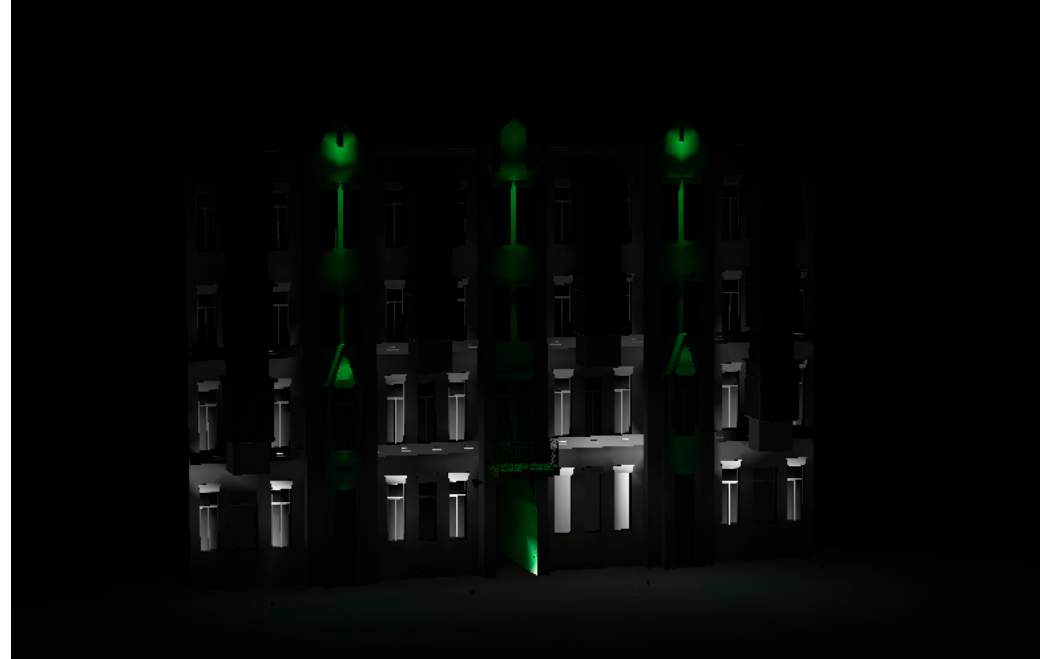
Figure 40. Energy and light pollution limitation scenario